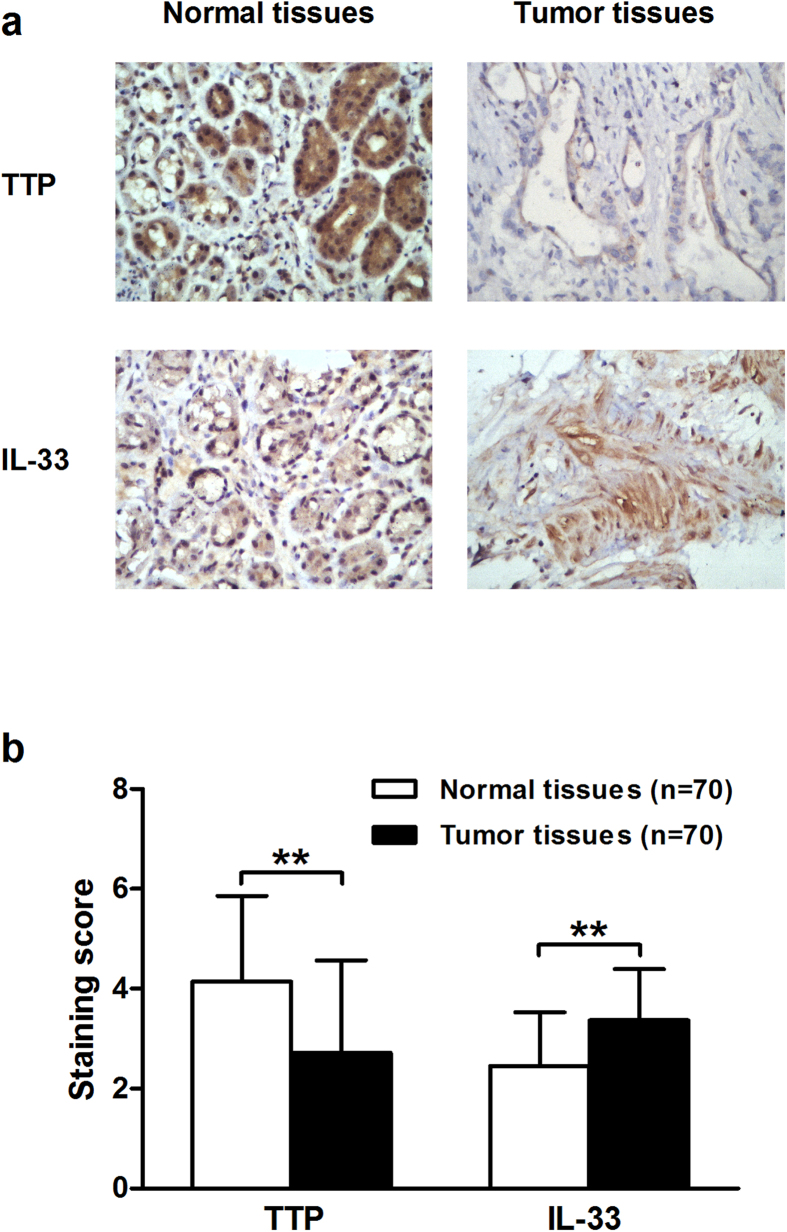
TTP expression is decreased and inversely correlated with IL-33 expression in gastric cancer (Group B).(a) Representative immunohistochemical staining of TTP (IHS: top left, 6; top right, 1) and IL-33 (IHS: bottom left, 1; bottom right, 4) in gastric cancer tissues and adjacent normal tissues (400× magnification). (b) The normal tissues showed strong positive staining of TTP, while the tumor tissues showed relatively stronger staining of IL-33. All data are represented as the mean ± SD. **P < 0.01.